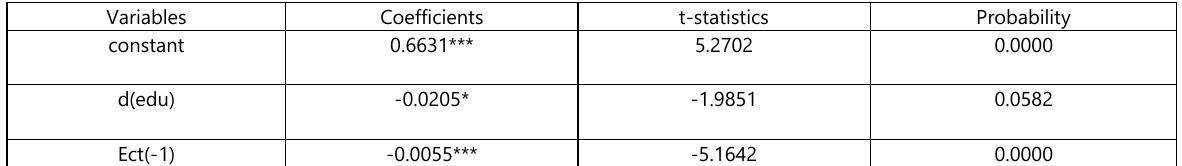
Table 3: Short-Term ARDL (1,1) Error Correction Model Estimates (Source: Author’s calculations) Variables